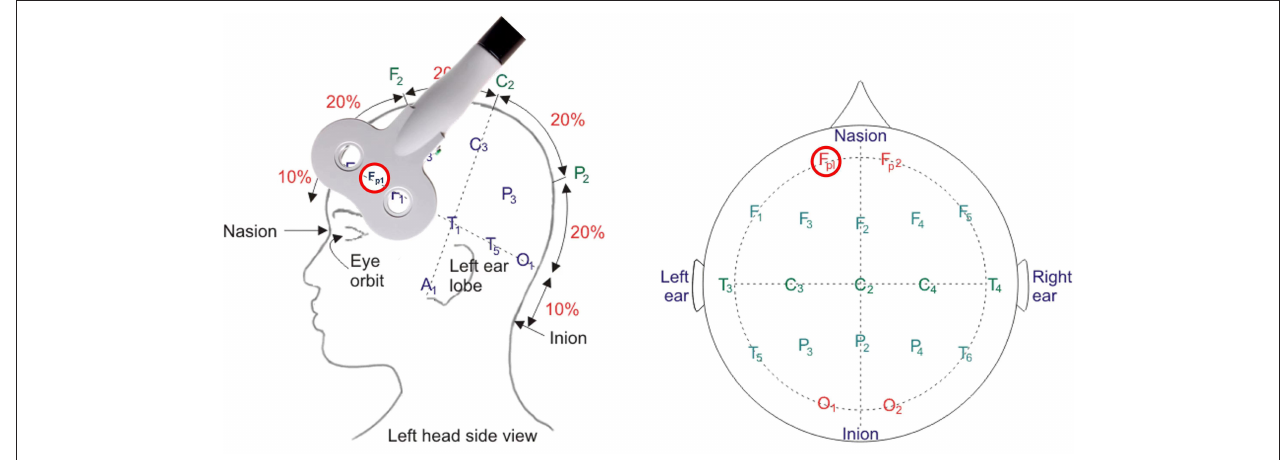
FIGURE 3 | The stimulation coil targeting Fp1 on EEG International 10–20 system